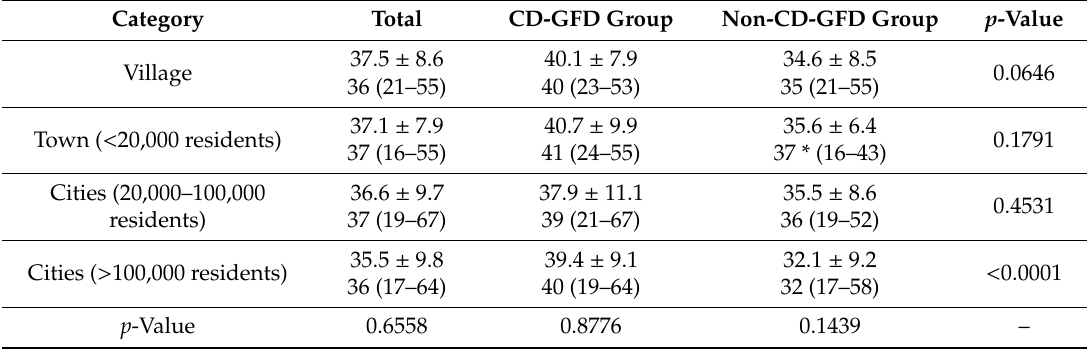
Table 7. Food Neophobia Scale (FNS) scores stratified by place of residence in the sub-groups of CD-GFD and non-CD-GFD individuals (mean ± SD and median accompanied by